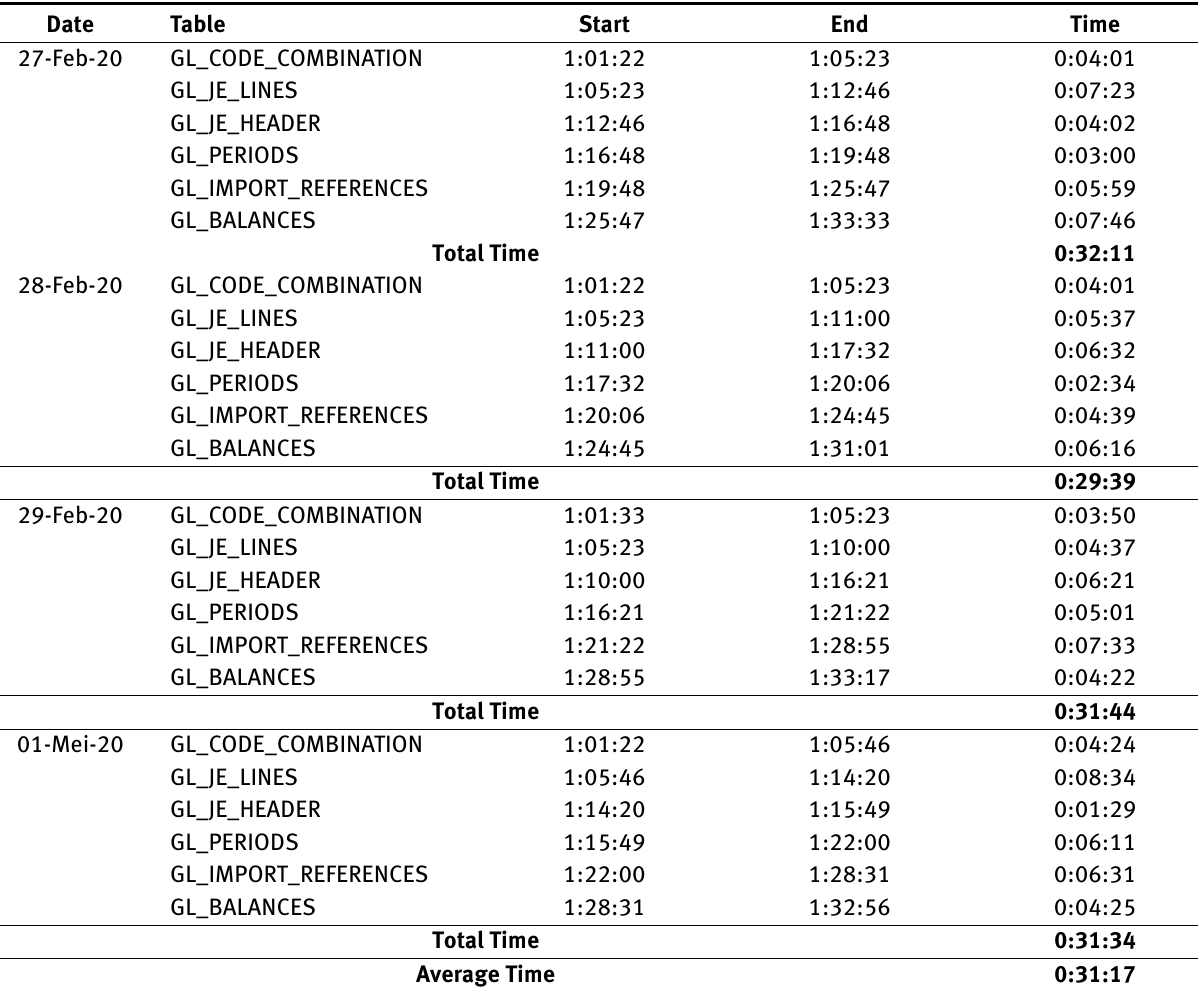
Table 3: Evaluation of data processing and visualization